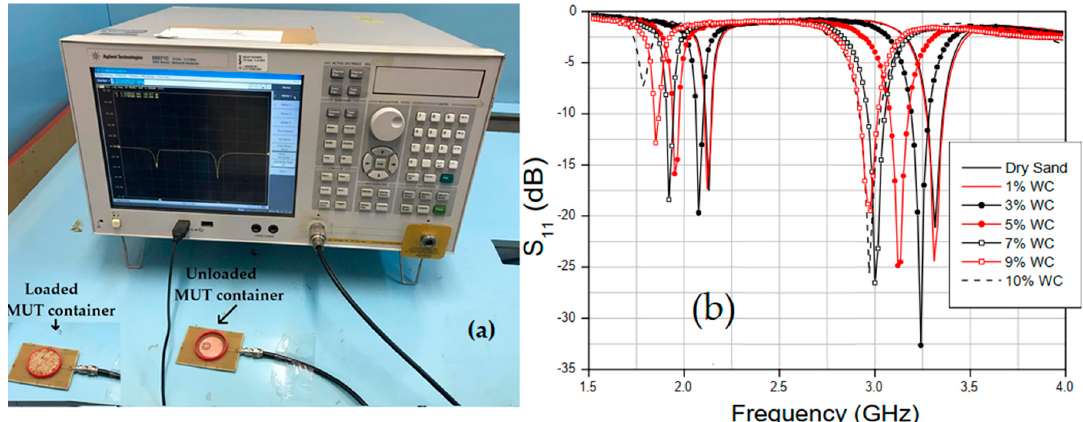
Figure 7. Quartz sand sample experimental procedure: ( a ) Measurement setup; ( b ) S 11 variation for different Soil Water Content (SWC).